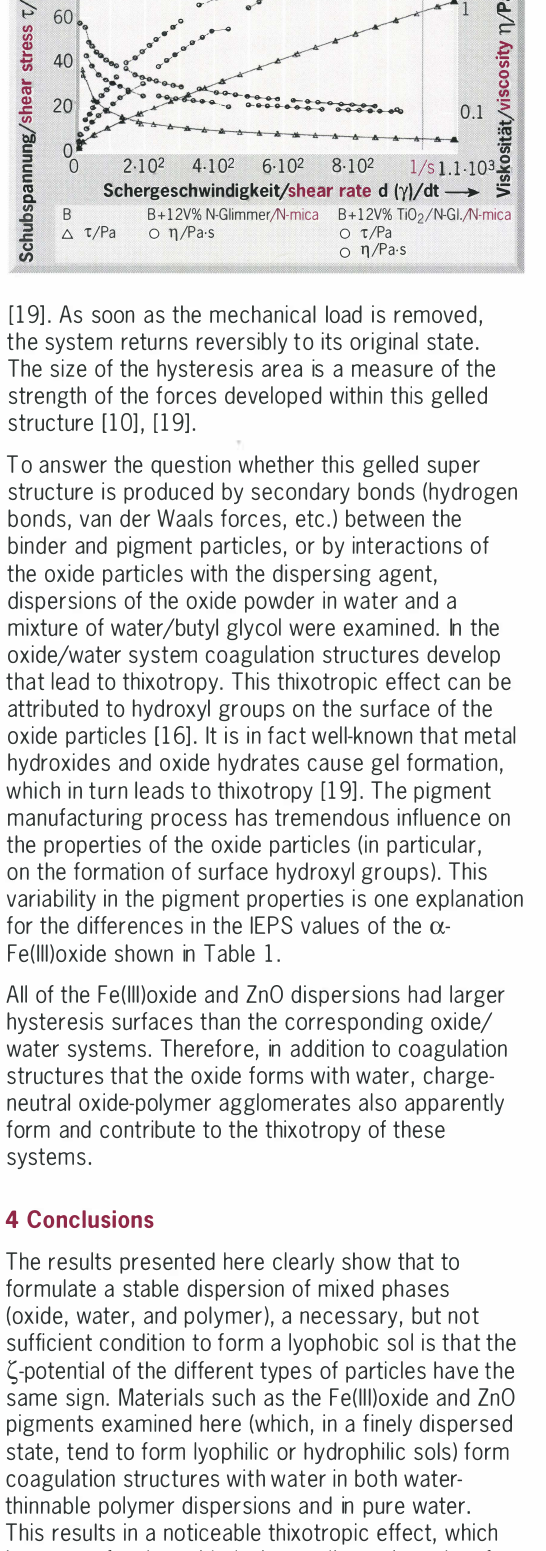
Fig. 5: Flow and viscosity curves of binder B with and without